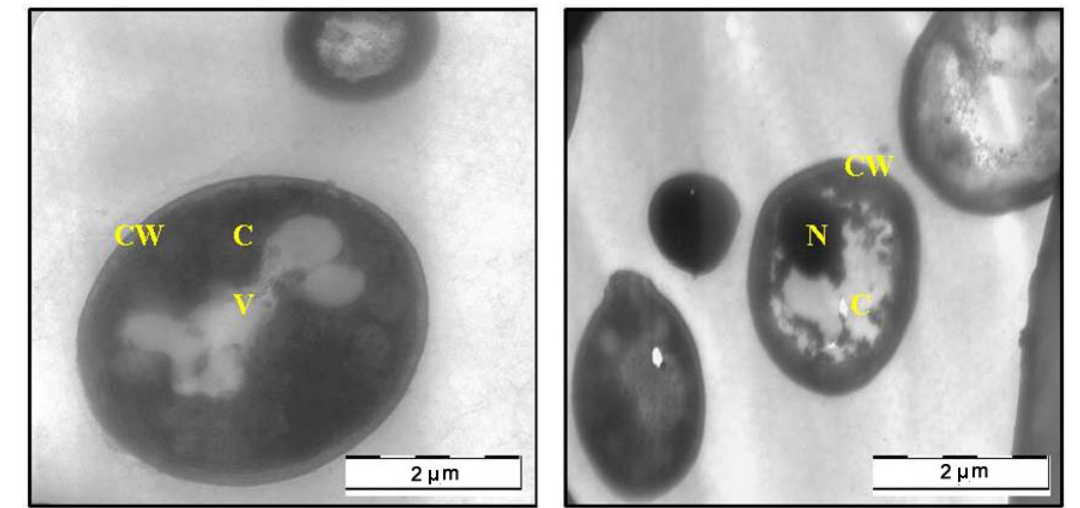
Figure 4. TEM micrograph of a cross-section of the extract treated cell of Candida albicans after 12 h (C: Cytoplasm; CW: Cell Wall; N: Nucleus; V: